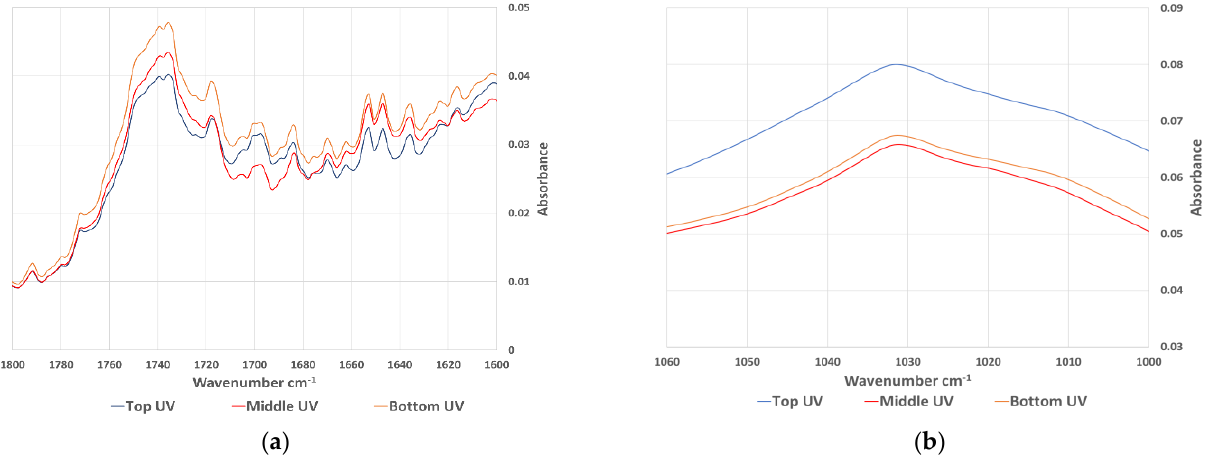
Figure 10. The ( a ) carbonyl and ( b ) sulfoxide peaks from FT-IR spectra of samples aged in the UV chamber.